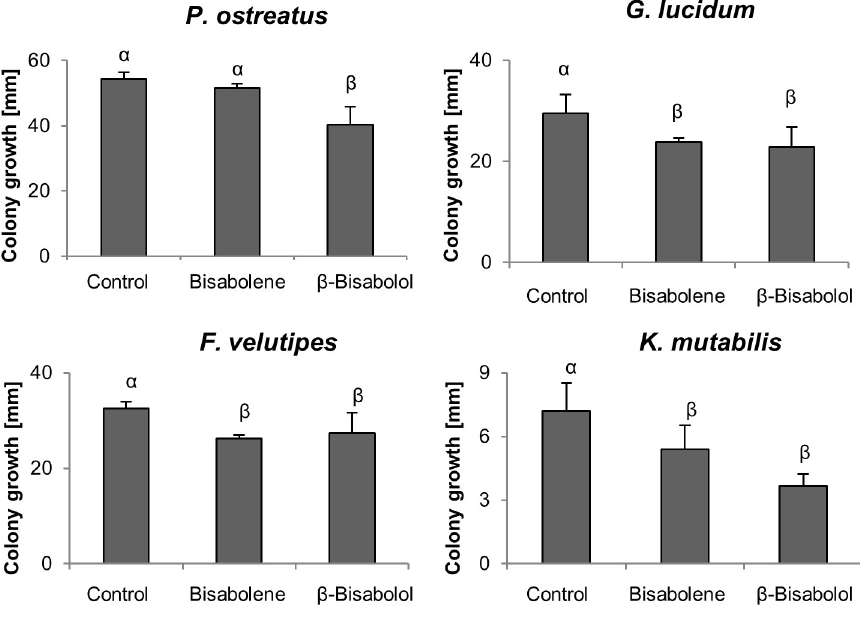
Fig 6. Effect of sesquiterpenes (-)-(1 R ,2 S ) β -bisabolol (40 mg l -1 ) and bisabolene (0.6 mg l -1 ) on the growth of indicator fungi. P < 0.05, n = 3 to 5.